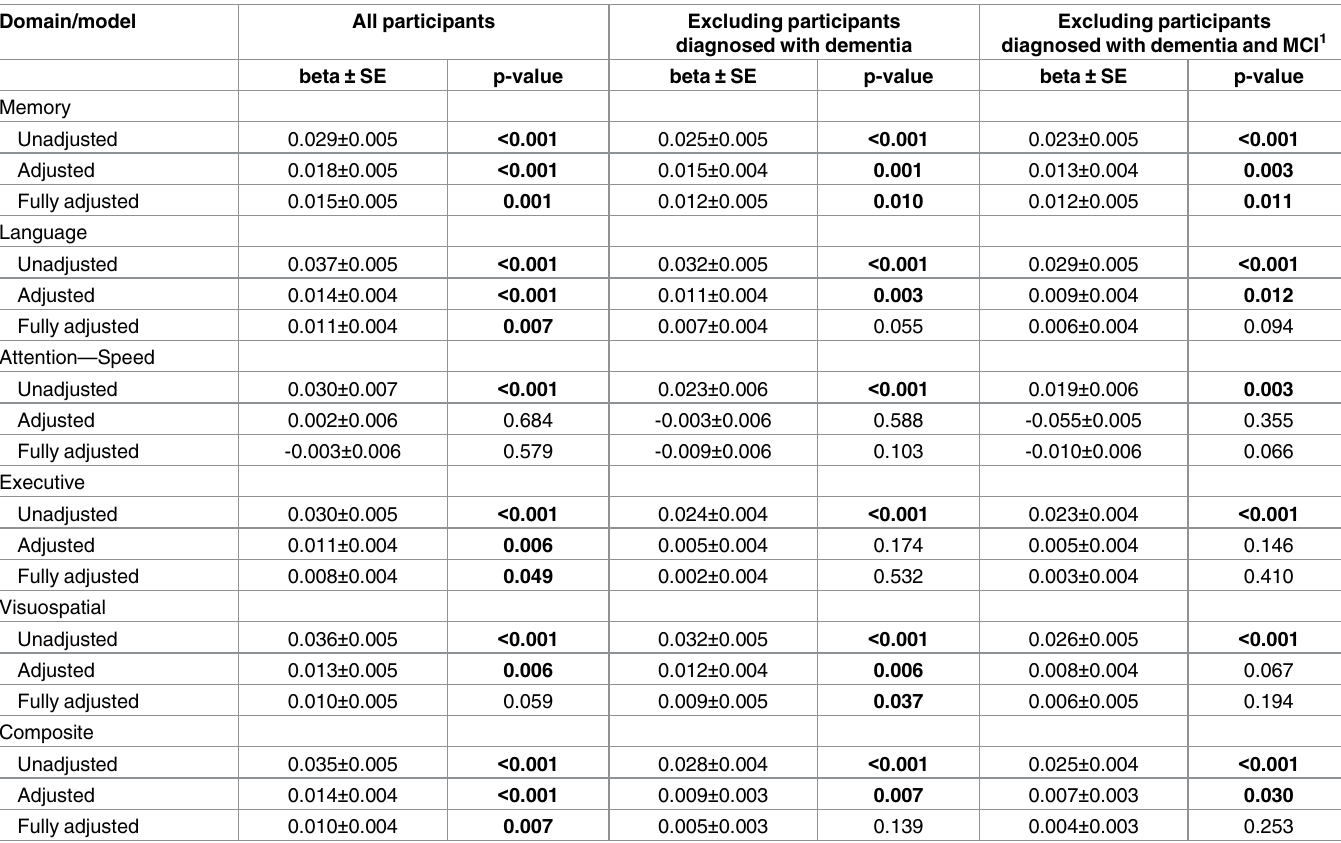
Table 4. Results from multiple linear regression analysis that evaluated the association between the Mediterranean dietary score and z scores of cognitive performance. Domain/model All